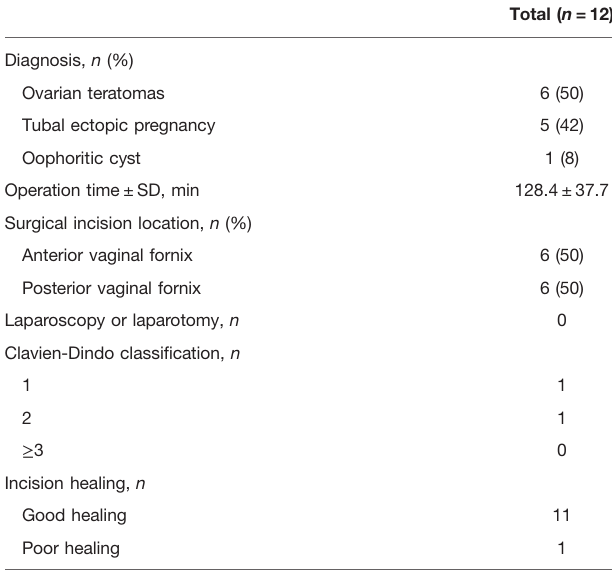
TABLE 2 | Surgical data and postoperative review results of 12